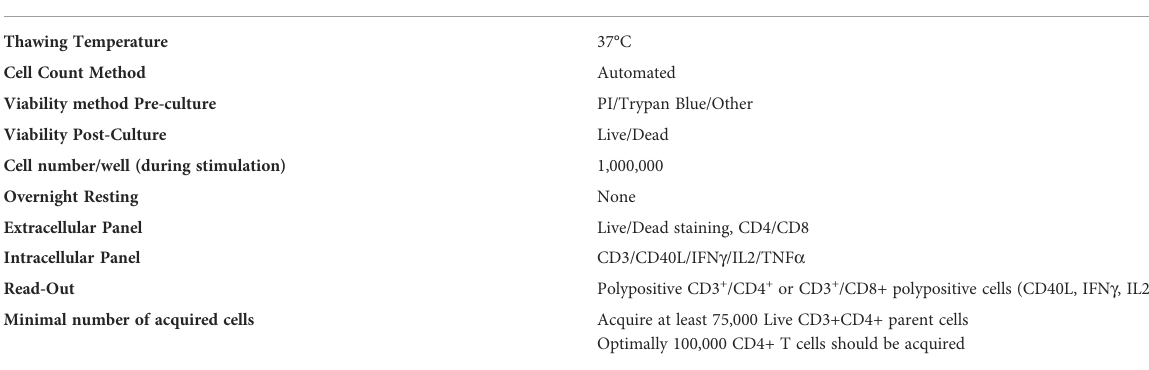
TABLE 2 Parameters selected for the ICS consensus